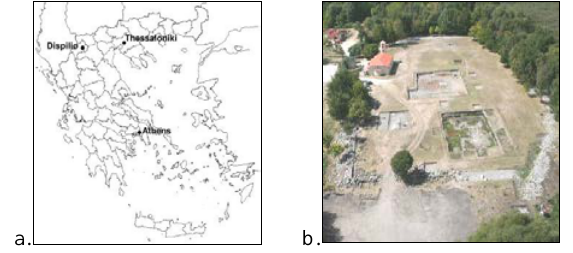
Figure 14. The enclosure and the deck used for the acquisition images.